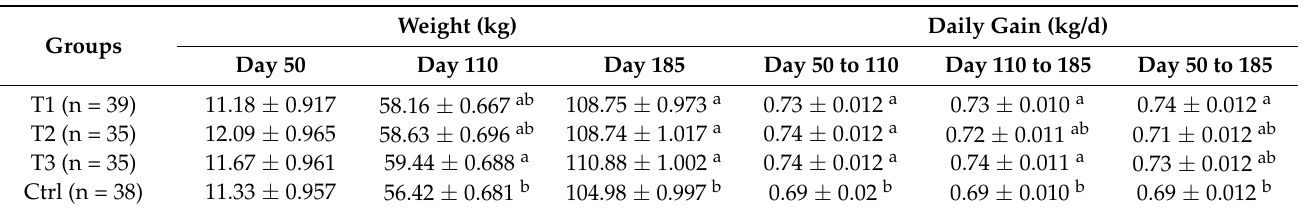
Table 4. Mean weight and daily gain of each period after immunisation of fattening pigs with different doses of SS DNA